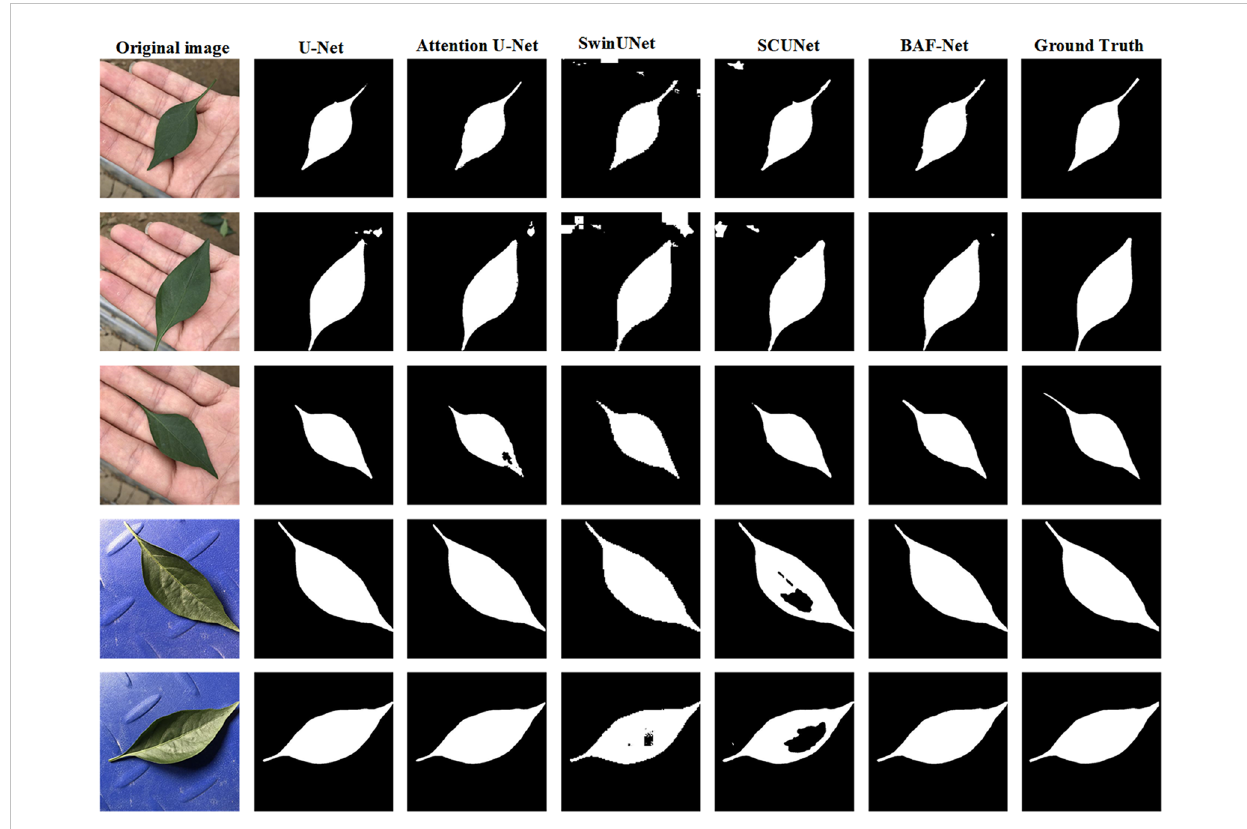
FIGURE 6 Examples of the predicted results using fi ve different model on the EBD dataset. From the 1 st column to 7 th column: the original image, the predicted results using the U-Net, attention U-Net, Swin-UNet, SCUNet, and our model,